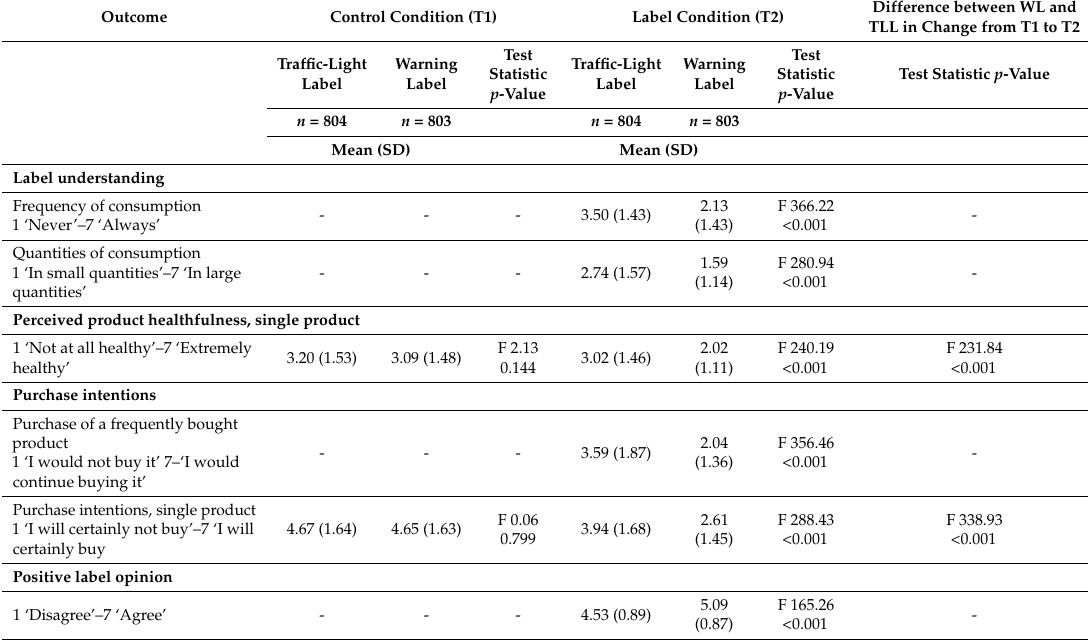
Figure 4. Product healthfulness score, measured in a product comparison task; p < 0.001 for differences between label conditions at T2.